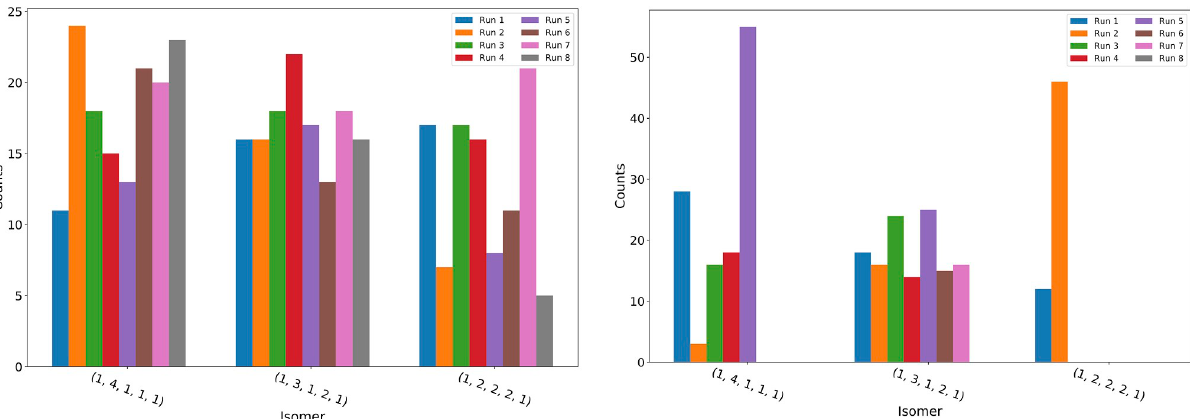
Fig 8. Sequential distributions of results. Distributions of returned isomers of Pentane ( C 5 H 12 ) after each run of 10,000 samples. Left: Not using QUBO perturbation, Right: Using QUBO perturbation.